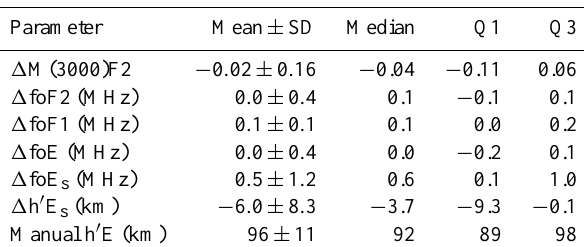
Table 2. Differences between manually scaled and Autoscala values (manual −